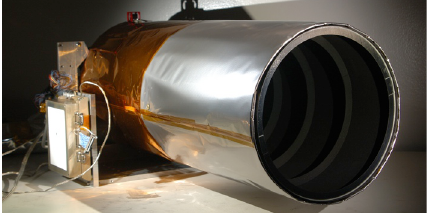
Figure 1. One of the two LROC NACs. The gold blanket covers the telescope and the silver portion is a baffle (27 cm in